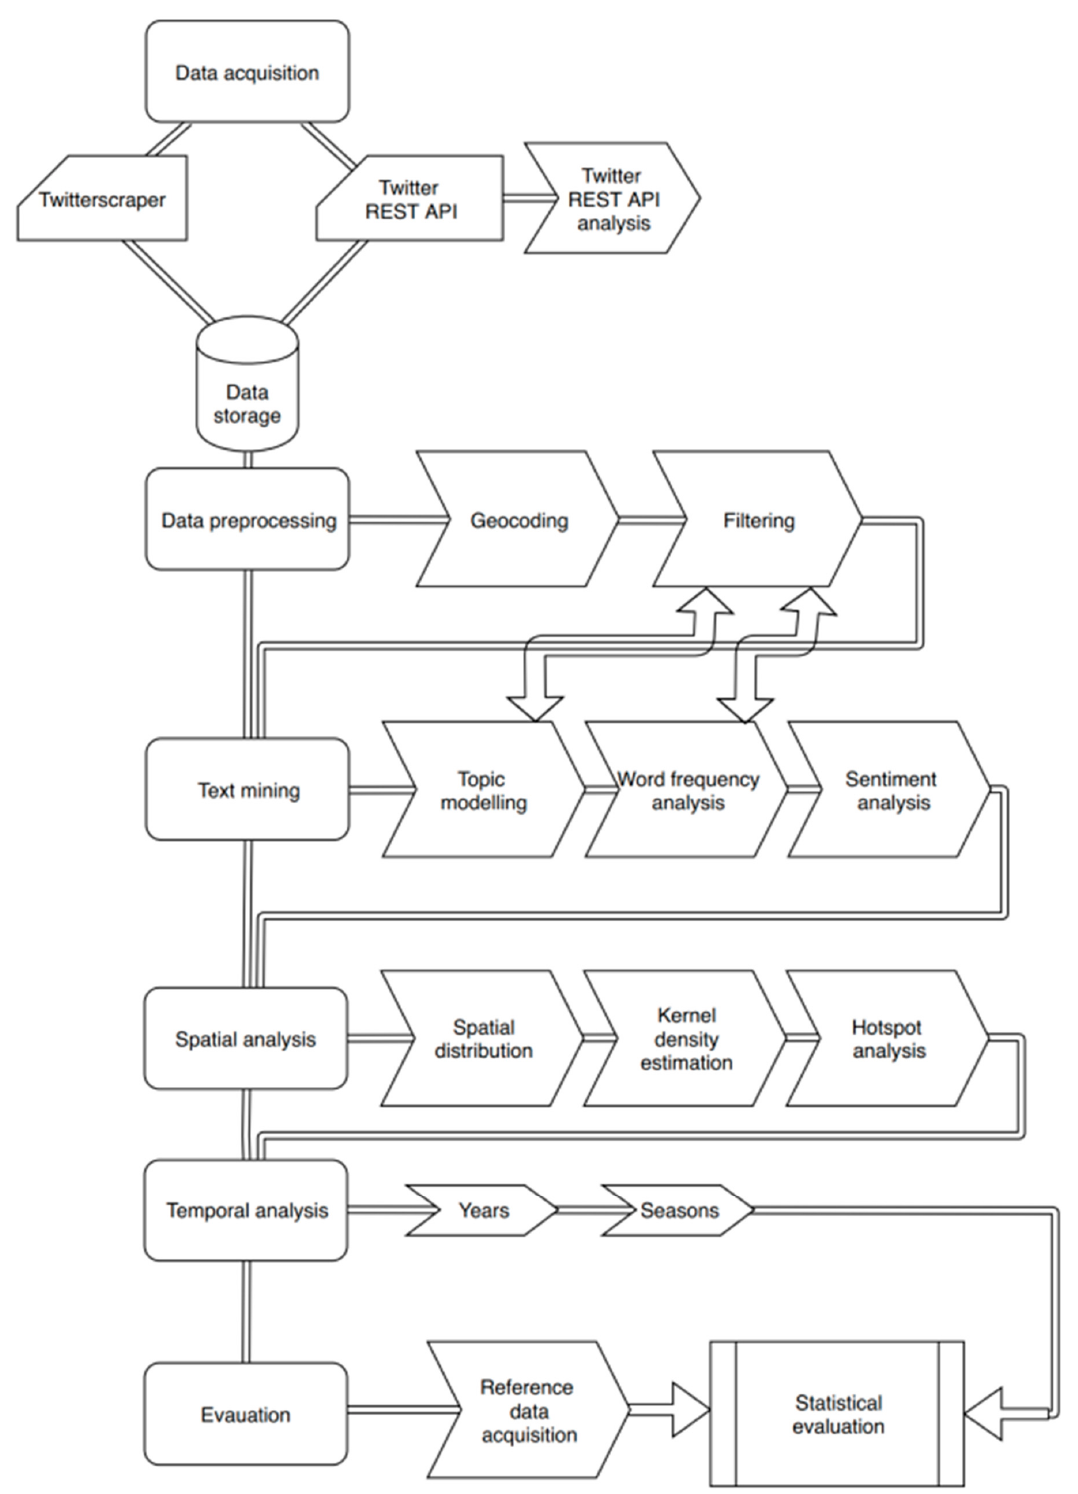
Figure 1. The overall methodology followed in this paper. The process starts with a data acquisition using Twitterscraper [35], based on location and tourism-related keywords on a municipal level. The data processing and filtering is done using a NoSQL document database. The Twitter data are analyzed in terms of spatial properties, whereas the text of the tweets is analyzed with a semantic text analysis. An evaluation seeks to analyze the correlation between the Twitter data and official statistical data on tourism.